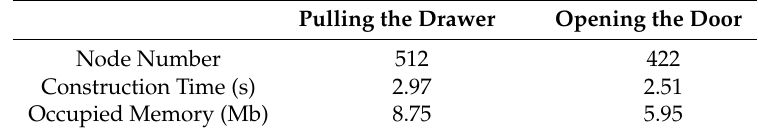
Table 3. The information of approximate graphs for passive chain constraint manifolds.